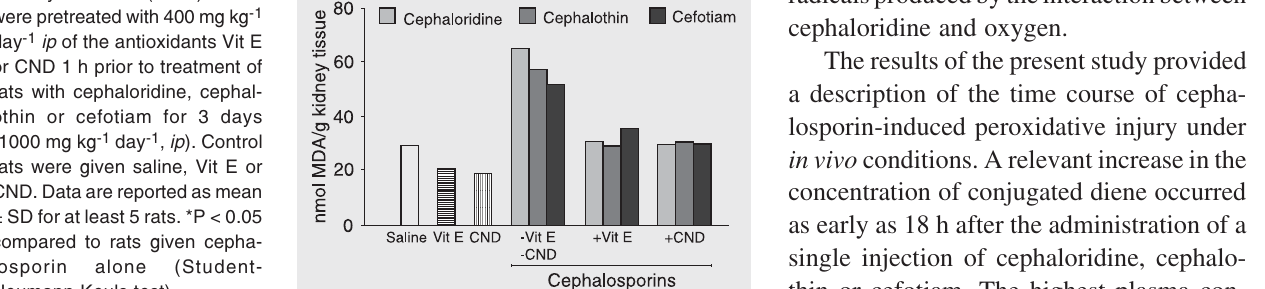
Figure 6. Inhibition of cepha- losporin-induced malondialde- hyde (MDA) production by the antioxidants vitamin E (Vit E) and cyanidanol (CND).